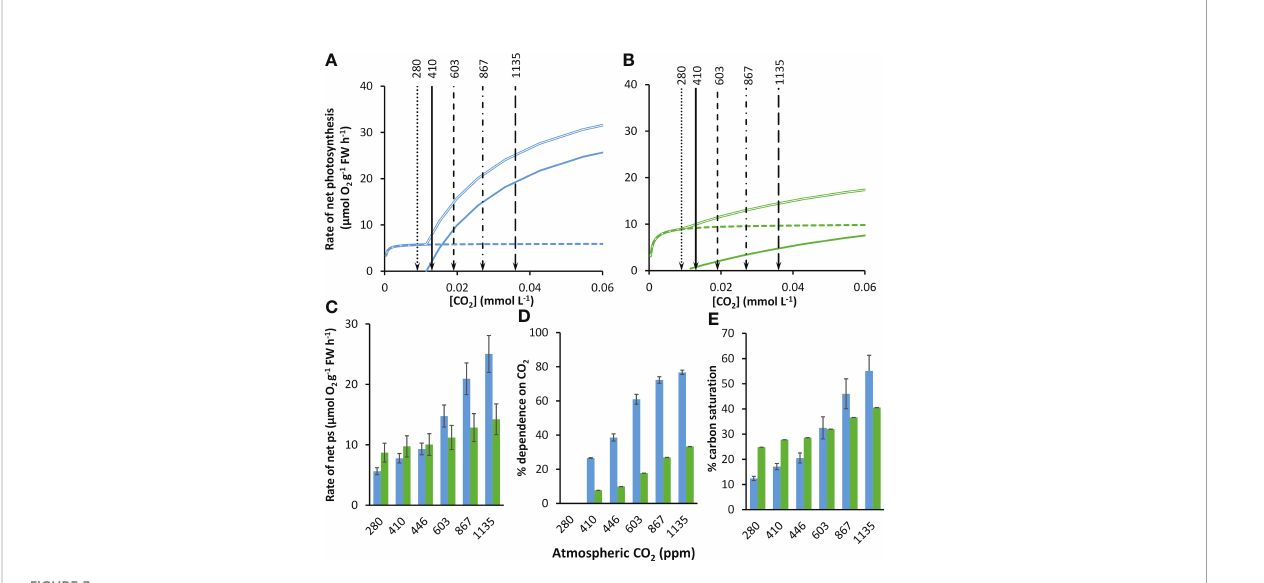
FIGURE 3 Modelled responses of photosynthesis by P. oceanica and Z. marina to increasing concentrations of atmospheric CO 2 . Responses of photosynthesis based on CO 2 (solid line), HCO − 3 (dashed line) and the sum of the two (double line) to rising CO 2 for P. oceanica (A) and Z. marina (B) . The atmospheric equivalent (ppm) is given at the top of the panels and indicated by lines and arrows; for clarity the 446 ppm line is not shown. Summary of results for P. oceanica (blue) and Z. marina (green) showing: rate of net photosynthesis (ps) (C) ; % dependence on CO 2 (D) ; and % inorganic carbon saturation (E) . See text for explanation of the atmospheric CO 2 ppm used. Error bars represent one standard